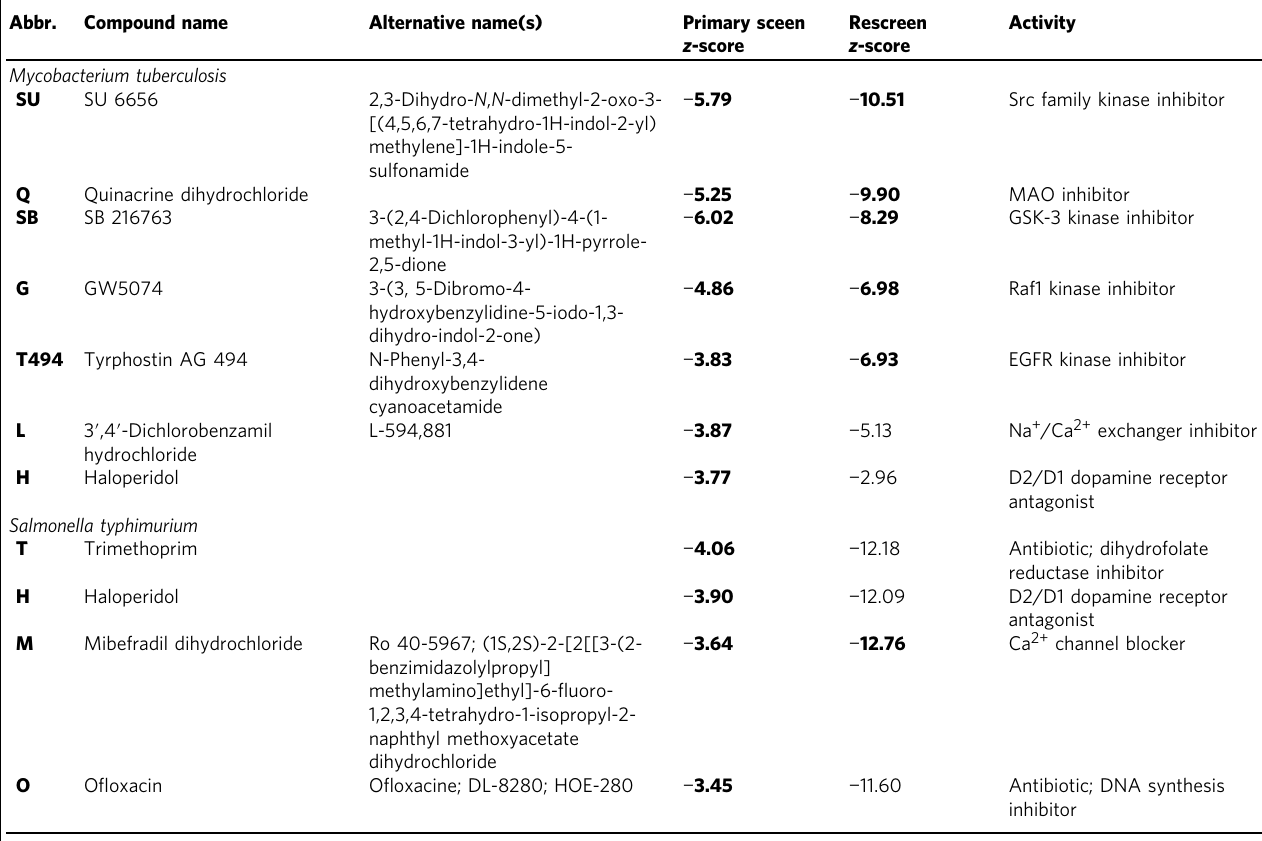
Z -scores lower than the z -score of H-89 are displayed in